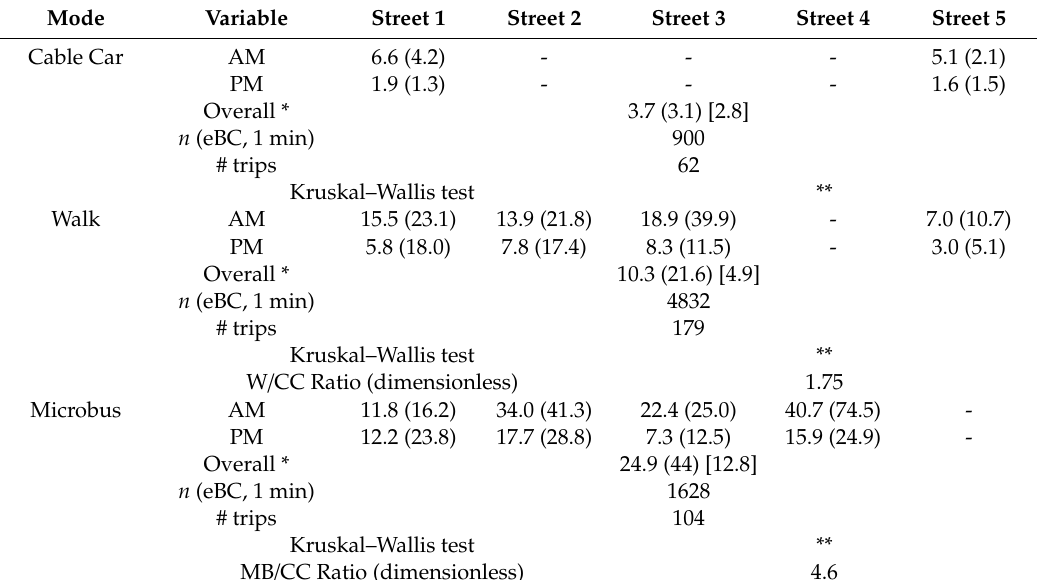
Table 3. Descriptive statistics showing the data availability, arithmetic mean (Mn), standard deviation (SD in parenthesis), arithmetic median (Mdn in square bracket) of exposure concentration ( µ g m − 3 ) at STP conditions on each of the routes, mode of transport, and sampling period. n = number of data points (1 min average); # trips = number of one-way trips; ratio of median values in reference to cable car ride.